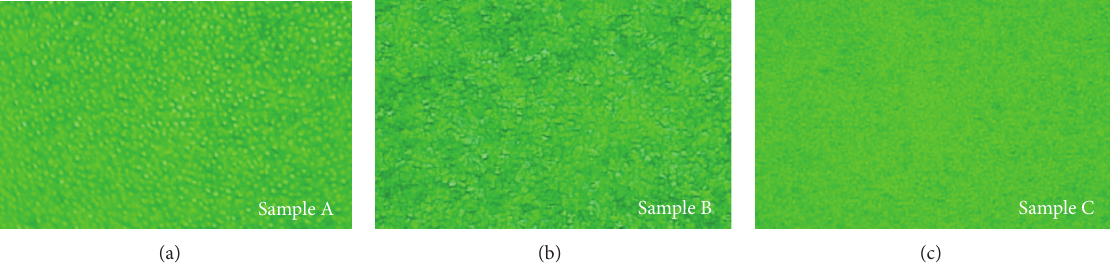
Figure 3: The FLM images for three samples. The selected wavelength of dichroic mirror is 430 nm and barrier filter is 450 nm in the test.